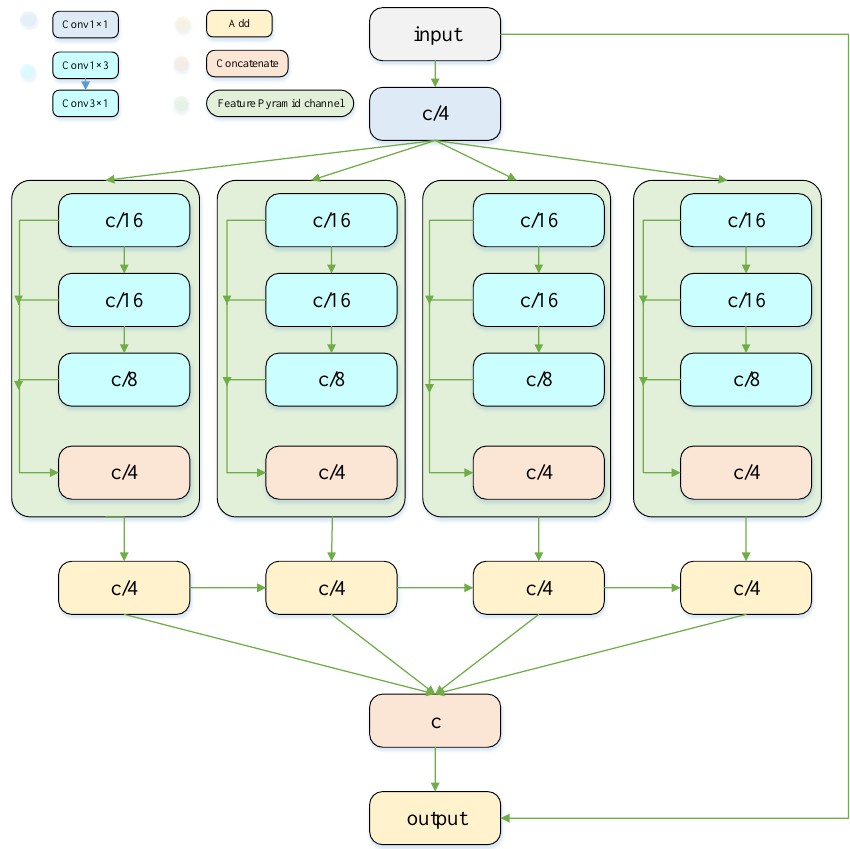
Figure 3. The structure of the CFP module. c is the number of channels of the input